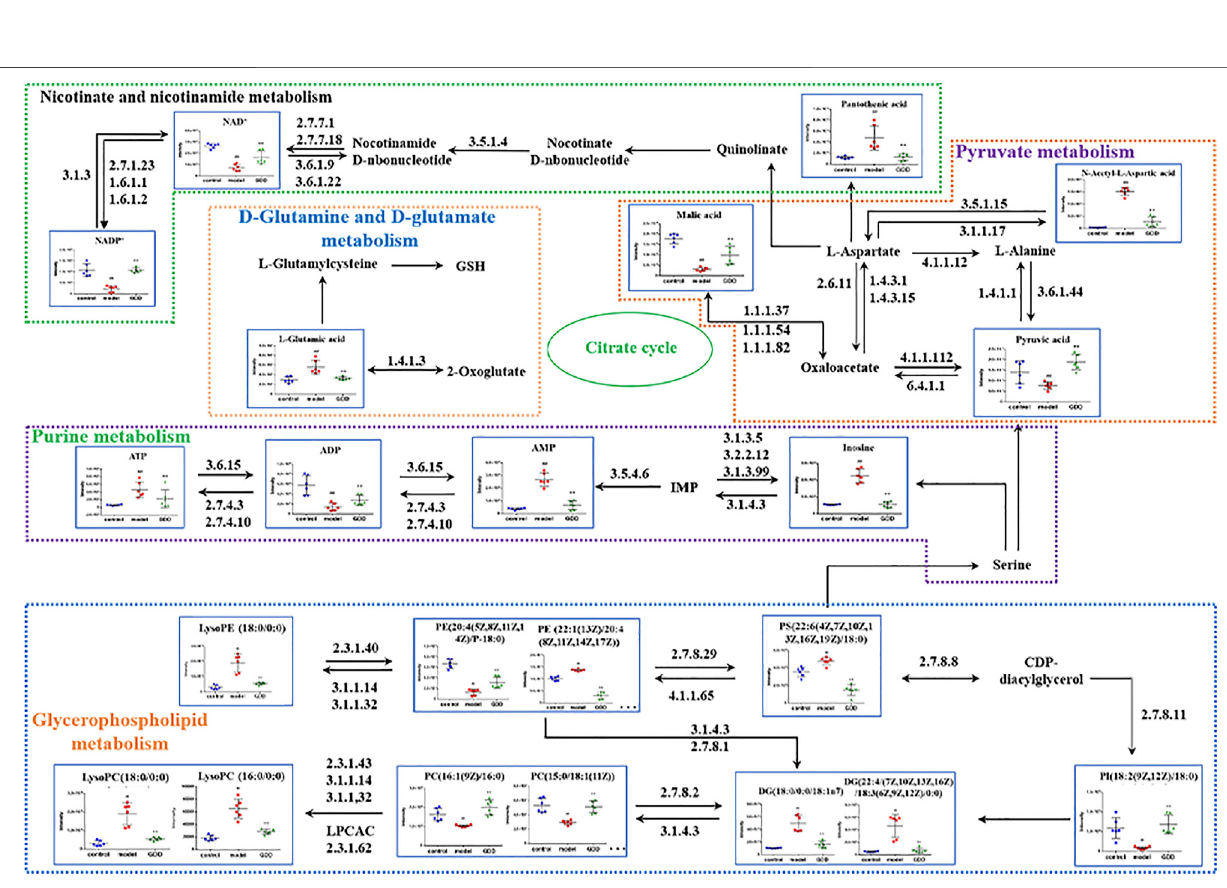
Frontiers in Pharmacology |